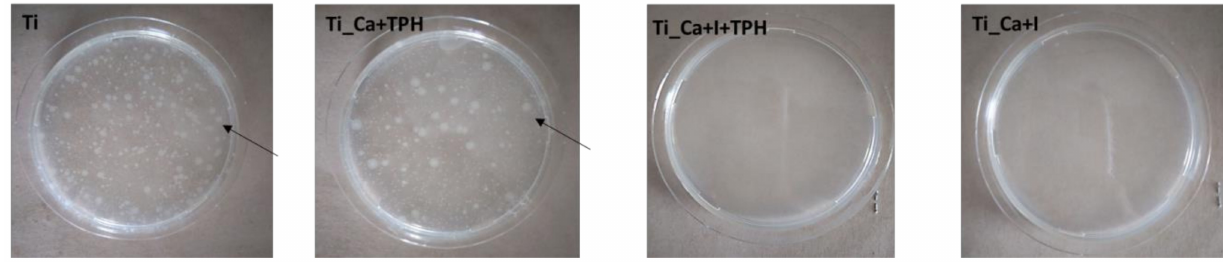
Figure 8. Optical images of colony formation on Ti, Ti_Ca+TPH, Ti_Ca+I+TPH, and